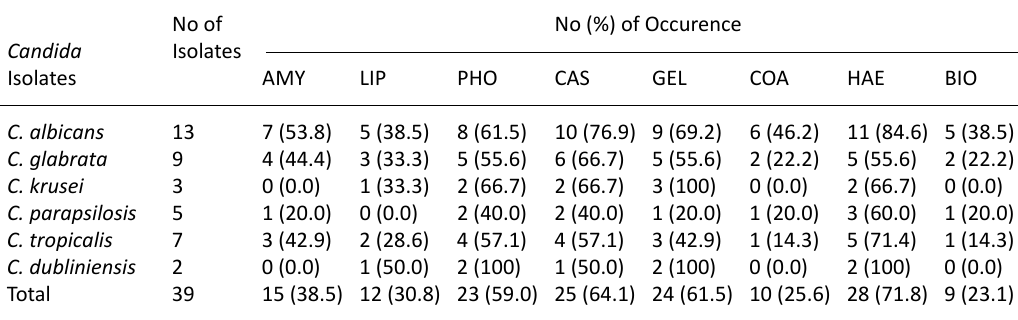
Table 6. Virulence Factors of Candida Isolates from Diabetic (Candiduric) Patients No of No (%) of Occurence Candida Isolates Isolates